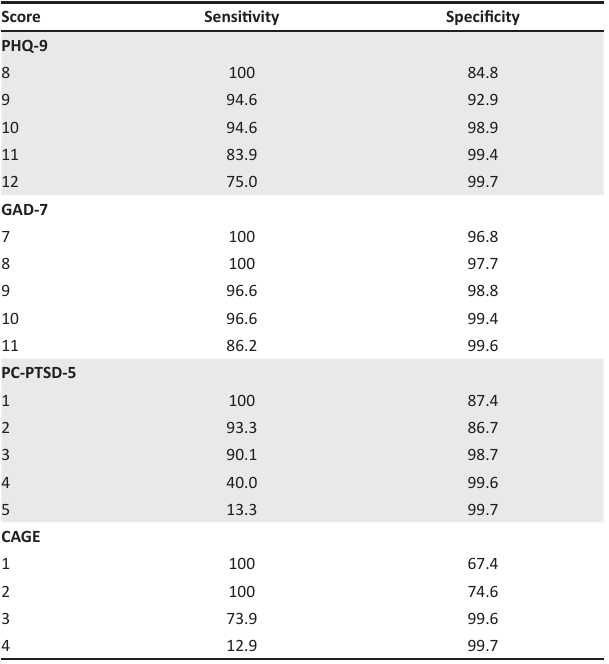
TABLE 6: Sensitivity and specificity indicators for PHQ-9, GAD-7, PC-PTSD-5, and CAGE. Score Sensitivity Specificity